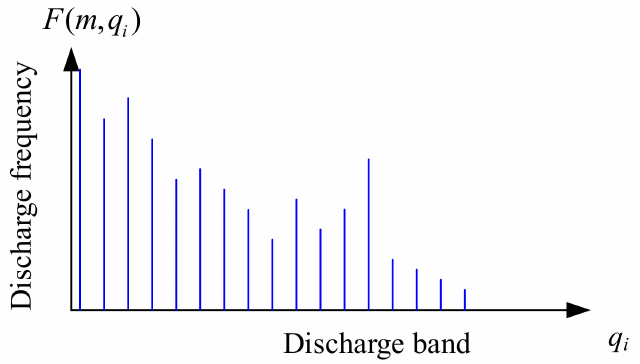
Figure 9. Schematic diagram of the discharge intensity